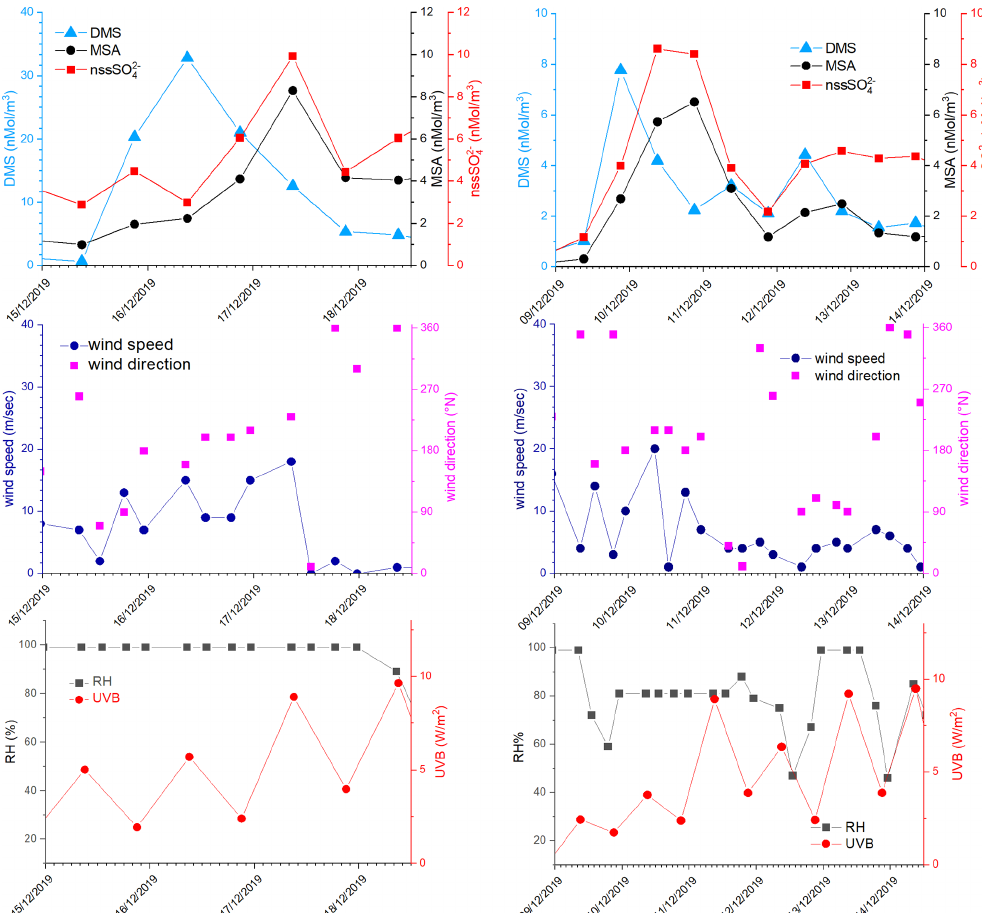
− , wind speed and direction, relative humidity (RH) and UVB for the time 15–19 December 2019 and Figure 6. DMS, MSA and nssSO 2 4 9–14 December 2019. DMS and UV-B data are averaged over the time interval of the corresponding aerosol sampling